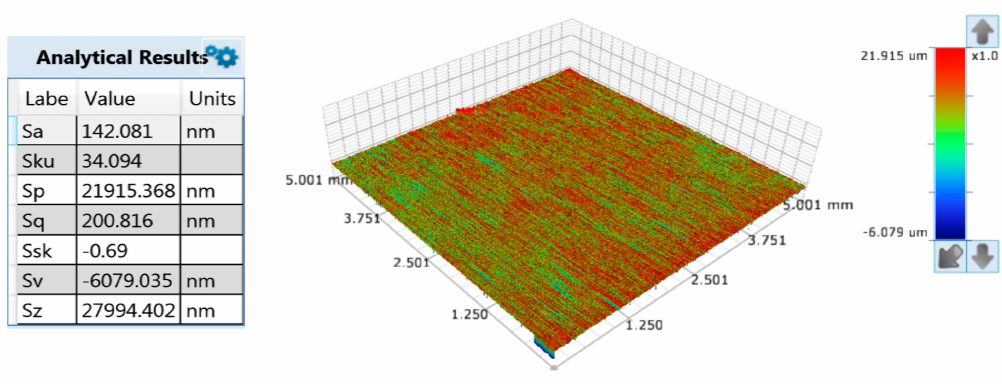
Figure 11. Measurement result of the semisphere.